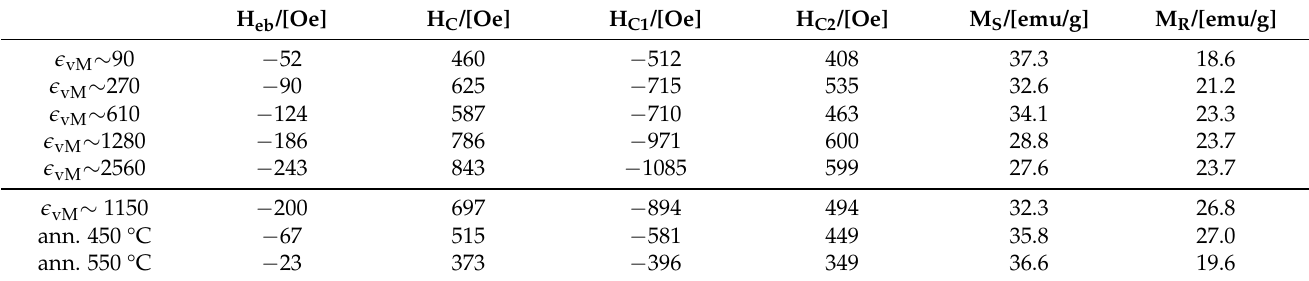
are shown in Figure 6a,b. Exchange bias (H eb ), symmetric coercivity (H C ), coercivity left side (H C1